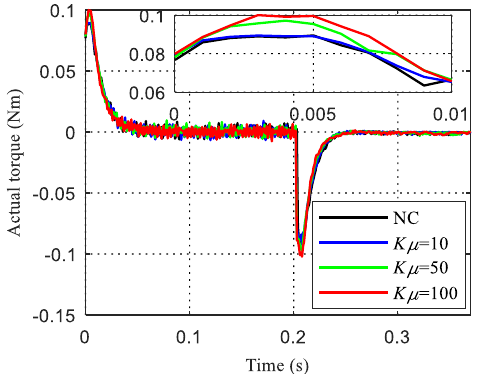
Figure 7. Actual motor torque at low velocities.